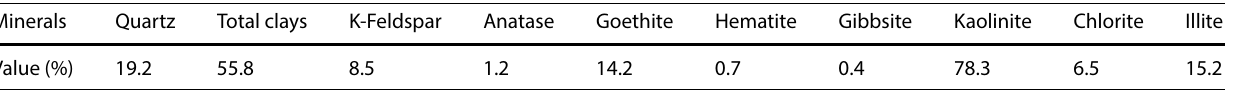
Table 3 Mineralogical composition of alluvial clays Minerals